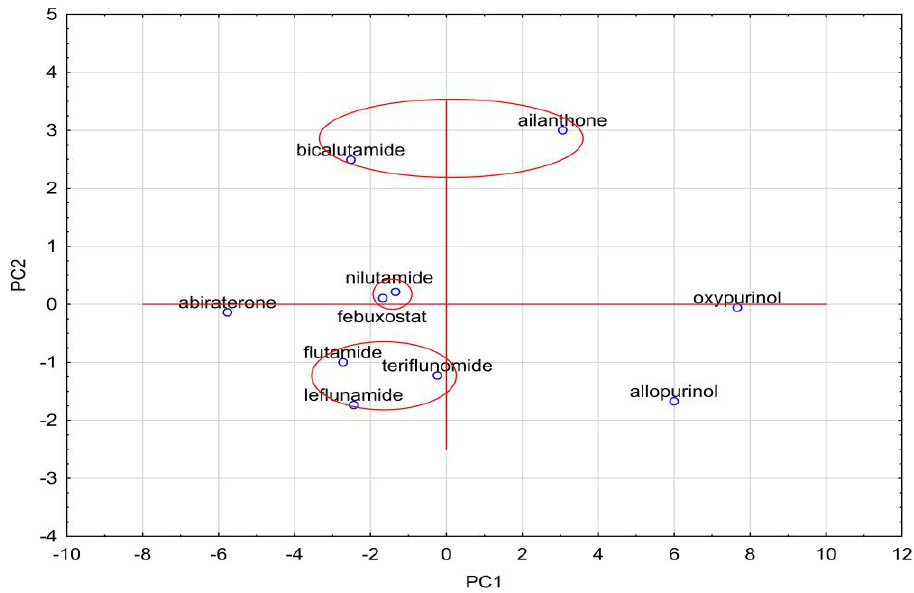
Figure 5. Plot of case projections on the plane of factors for all analyzed data.